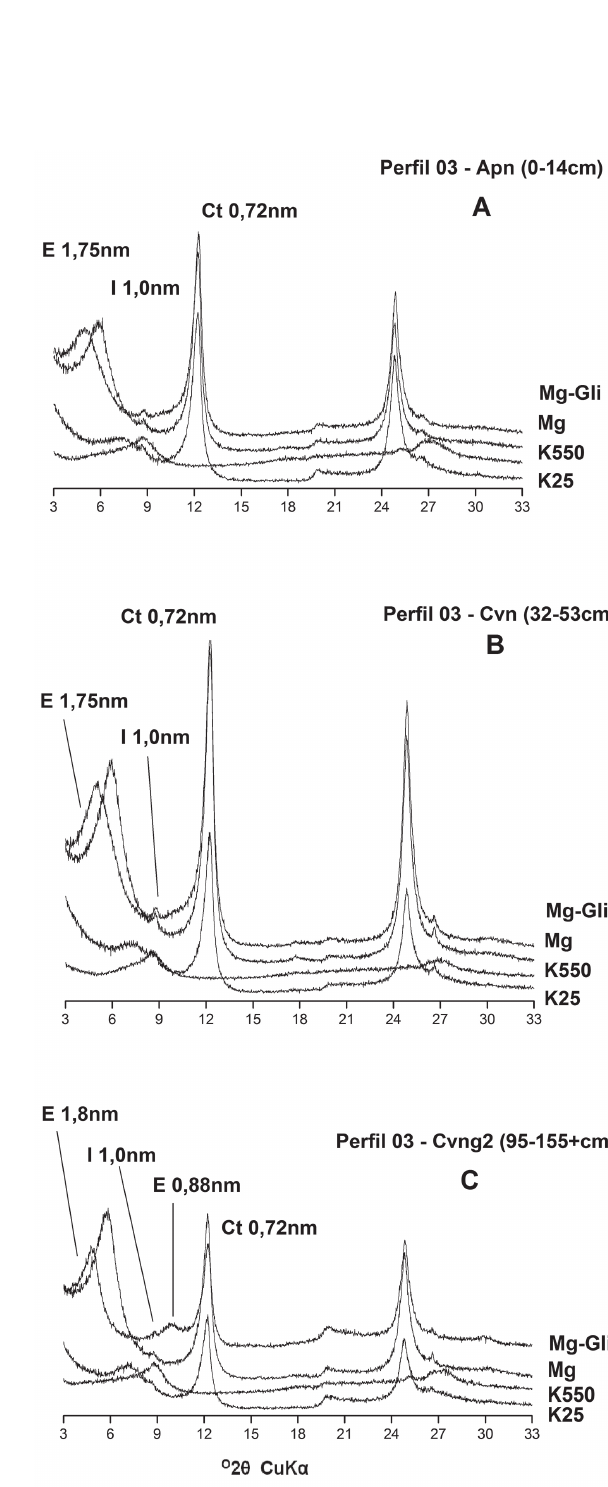
Figura 5. Difratogramas de raios-X da fração argila do perfil 03 - VXn gleissólico (E-esmectita; I-ilita; e Ct-caulinita).